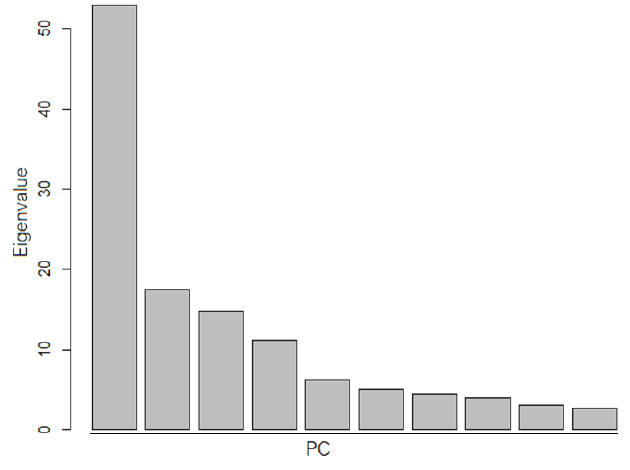
Figure 4. The scree plot f or TITS.